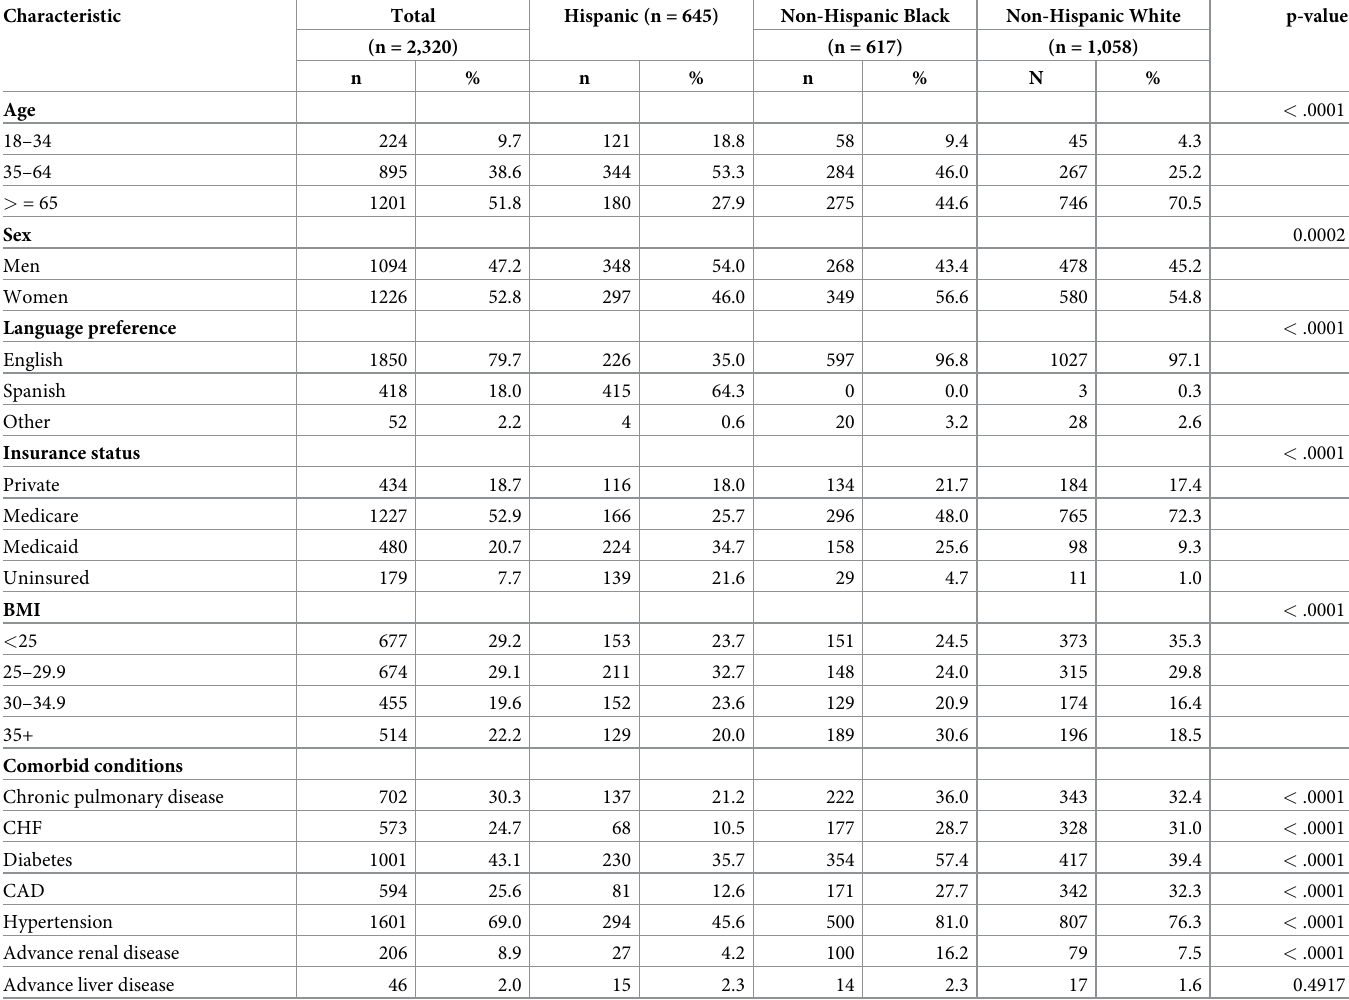
Table 2. Characteristics of COVID+ patients by